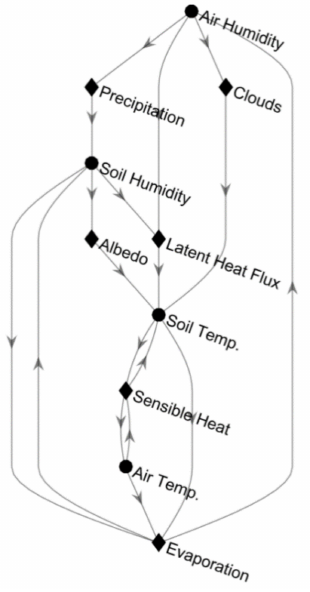
Figure 1. Conceptual scheme of interconnections among the main variables involved in the studied land surface-atmosphere feedbacks (LAF), adapted as a graph from [48] and hierarchized by a number of connections of each variable. The state (process) variables are denoted as circles (diamonds)